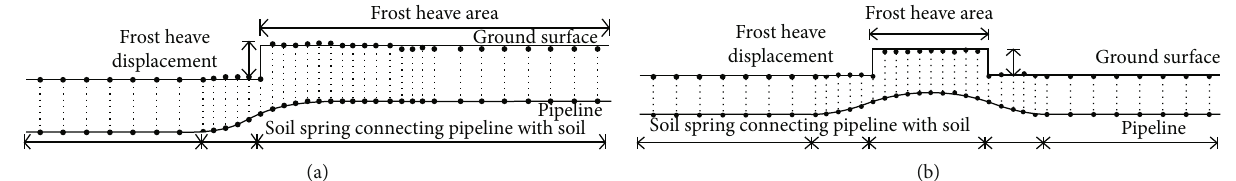
Figure 1: Schematic diagram for buried pipeline subjected to di ff erential frost heave: (a) semi-in fi nite length model and (b) fi nite length model.